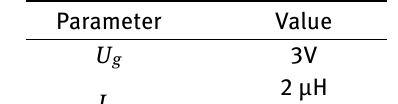
Table 3: Parameters to study the influence of stray inductance